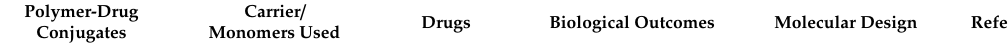
Table 2. Summary of polymer-drug conjugates e ffi cacy on breast cancer in vitro and in